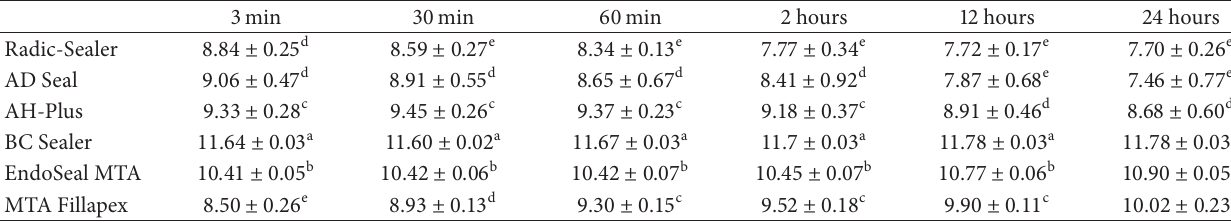
Table 5: pH change of freshly mixed samples during 24 hours.